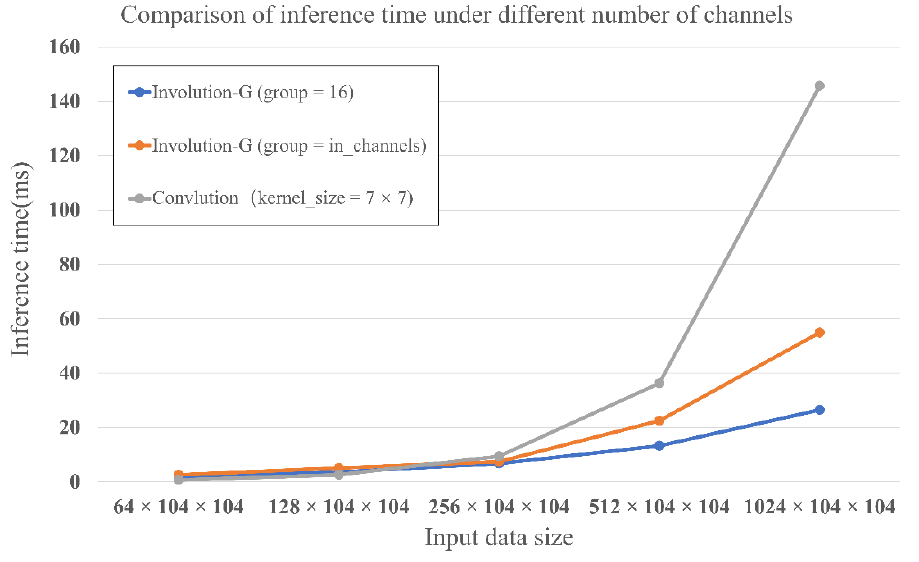
Figure 17. Inference speed of convolution and involution-G operators under the same size feature maps with a different number of channels.